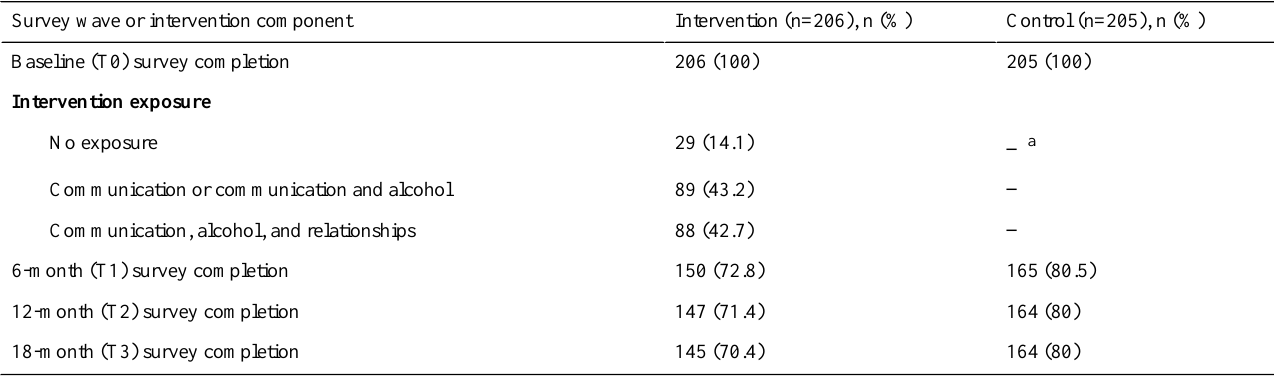
Table 1. Intervention dosage and survey completion